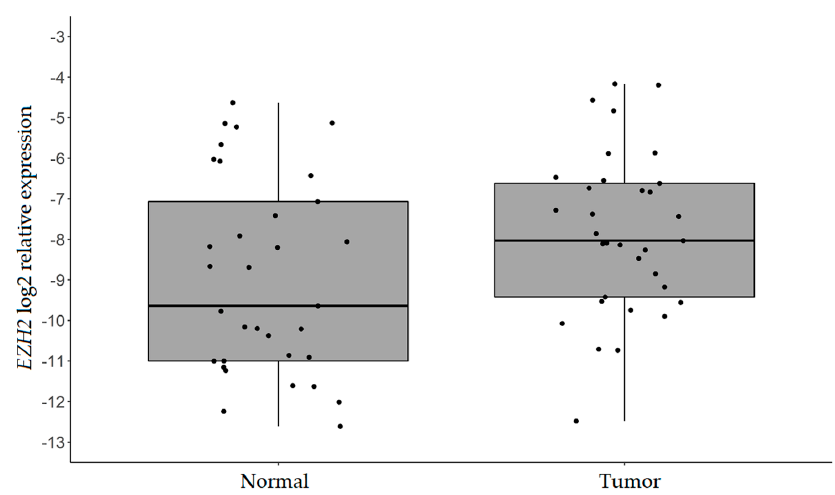
Figure 4. EZH2 expression analysis by RT-qPCR. Box plots of the log2 relative expression (2 − ∆ Ct ) of EZH2 in neoplastic and matched normal tissues of 33 IGC patients. B2M was used as the internal control. p -value = 0.005 (paired student’s t -test).